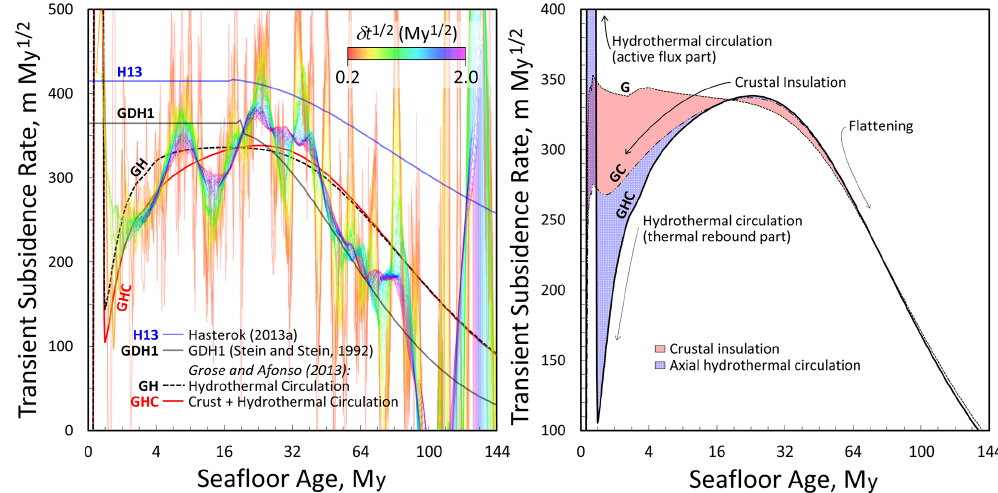
Figure 6. (a) Subsidence rates for models GH and GHC (Grose and Afonso, 2013), the classical model GDH1 (Stein and Stein, 1992), and the new heat-flow-constrained plate model of Hasterok (2013b), compared with subsidence rates estimated from the global depth data set of Hillier (2010). Red–yellow colors correspond to small sliding windows, and blue–violet colors correspond to large sliding windows over which subsidence rates are determined using a least-squares fit. The small discontinuities around 20My for GHD1 and H13 are due to the imperfect fit of their author’s respective equations for seafloor depth. (b) Comparison of model predictions of model GHC, GC, and G. Models GC and G have not been used to calculate hydrothermal power loss but are included here to clarify the role of hydrothermal circulation and crustal insulation on seafloor